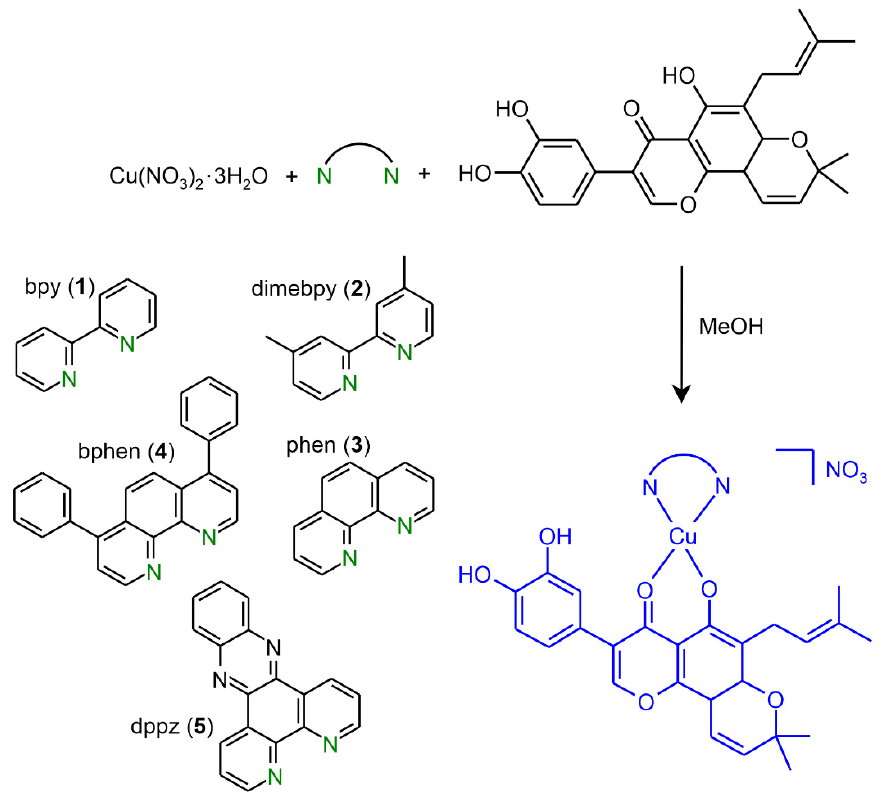
atoms of the N-donor